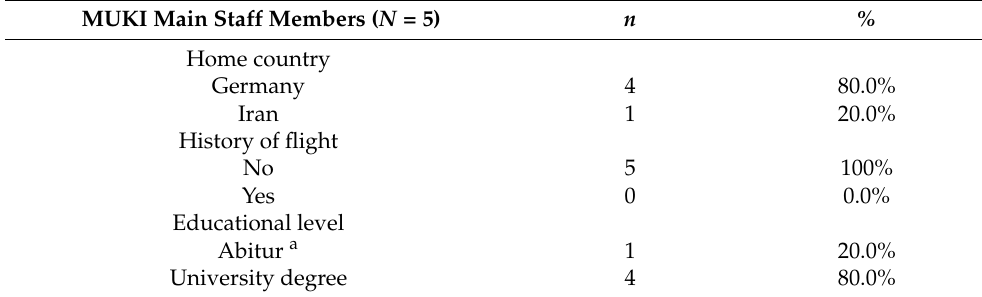
Table 2. Sociodemographic sample description of the MUKI staff ( N =